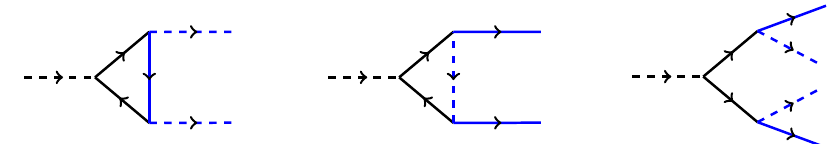
Figure 1 . Examples of in(cid:13)aton decay channels forbidden by the discrete interchange symmetry. For clarity, we represent the light Higgs and neutrino (cid:12)elds in blue and the in(cid:13)aton and right-handed neutrinos in